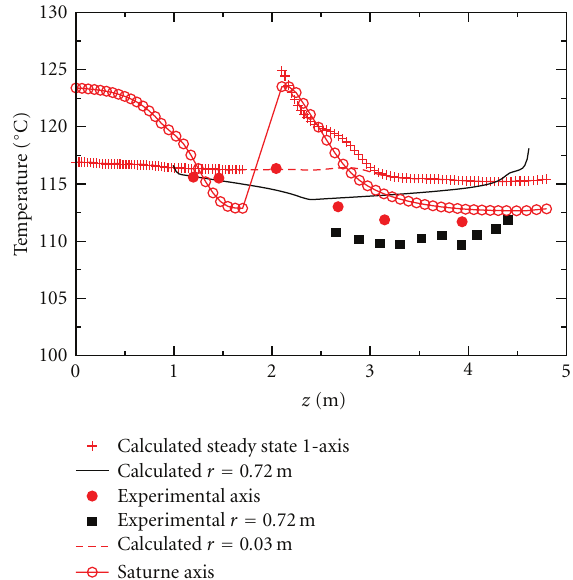
Figure 9: Vertical profile of the gas temperature along the axis: steady state 1.